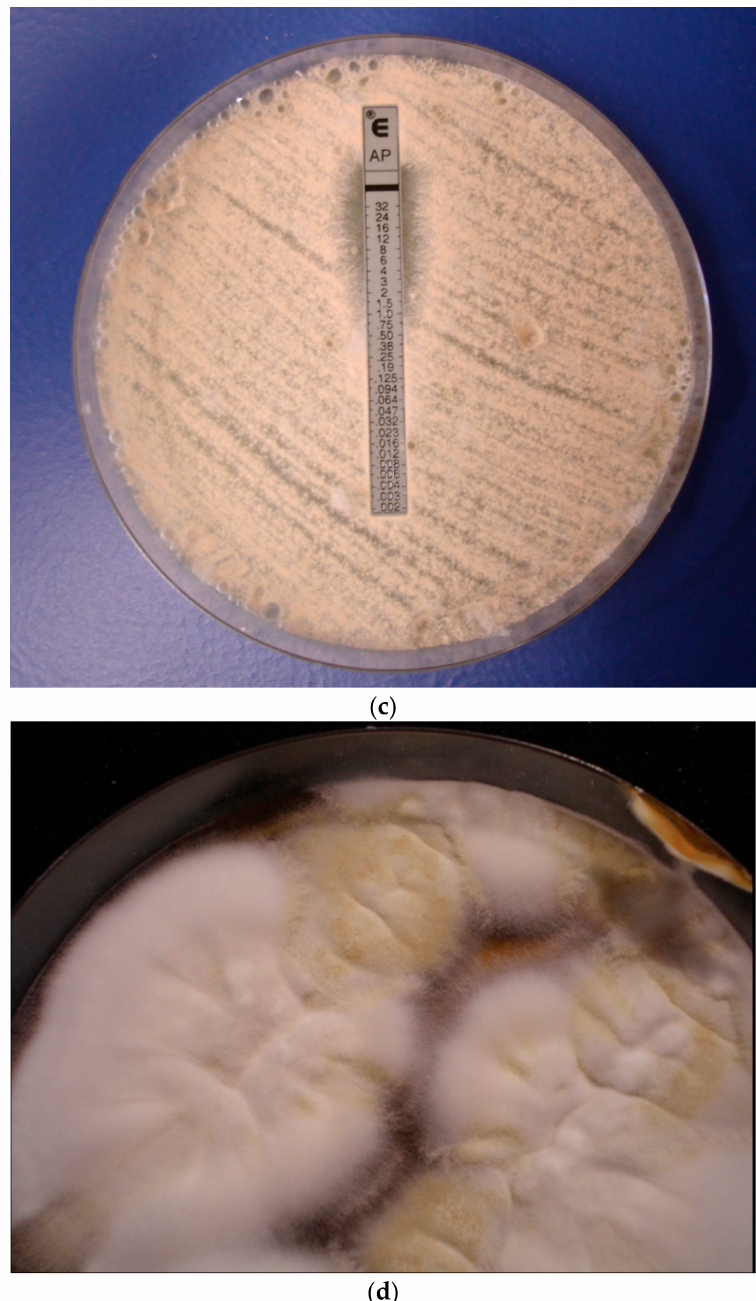
Figure 1. ( a – d ) A. terreus sensu strictu displaying typical culture morphology on Sabouraud Agar (48 h/37 ◦ C) ( a ) and wet mount preparation with lactophenol cotton blue showing aleuroconidia (light microscopy, magnification × 1000) ( b ), E-Test ® showing amphotericin B resistance ( c ) and the performance of sectoring by the production of white, fluffy, and conidia-sparse colonies ( d ). The reason for this specific epidemiological situation is unclear. A. terreus strains isolated from environmental and clinical sources were genotyped using a novel panel of short tandem repeats [9]. Three major endemic genotypes collected from the Inn region and its side valleys were found to cause the majority of invasive A. terreus diseases in Tyrol, Austria. The genotypes were of the same mating type and persisted for at least 11